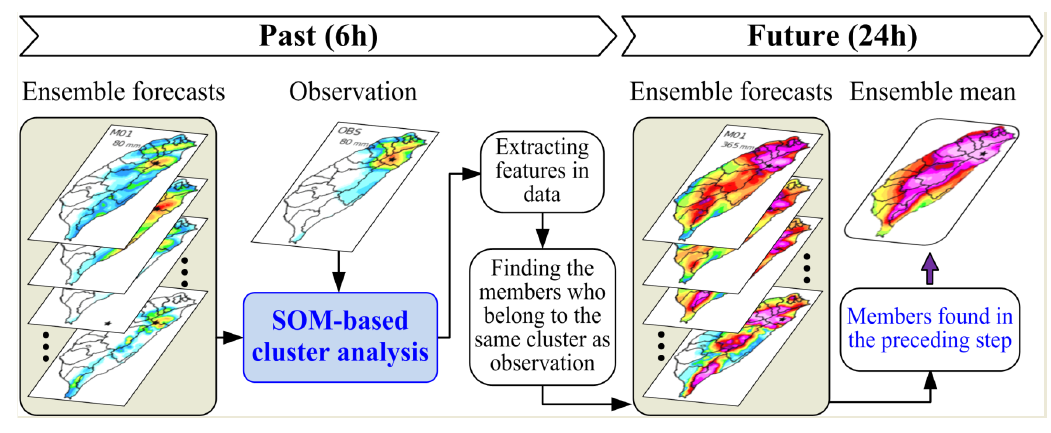
Figure 3. Illustration of the proposed artificial neural networks (ANN)-based strategy for effective use of ensemble